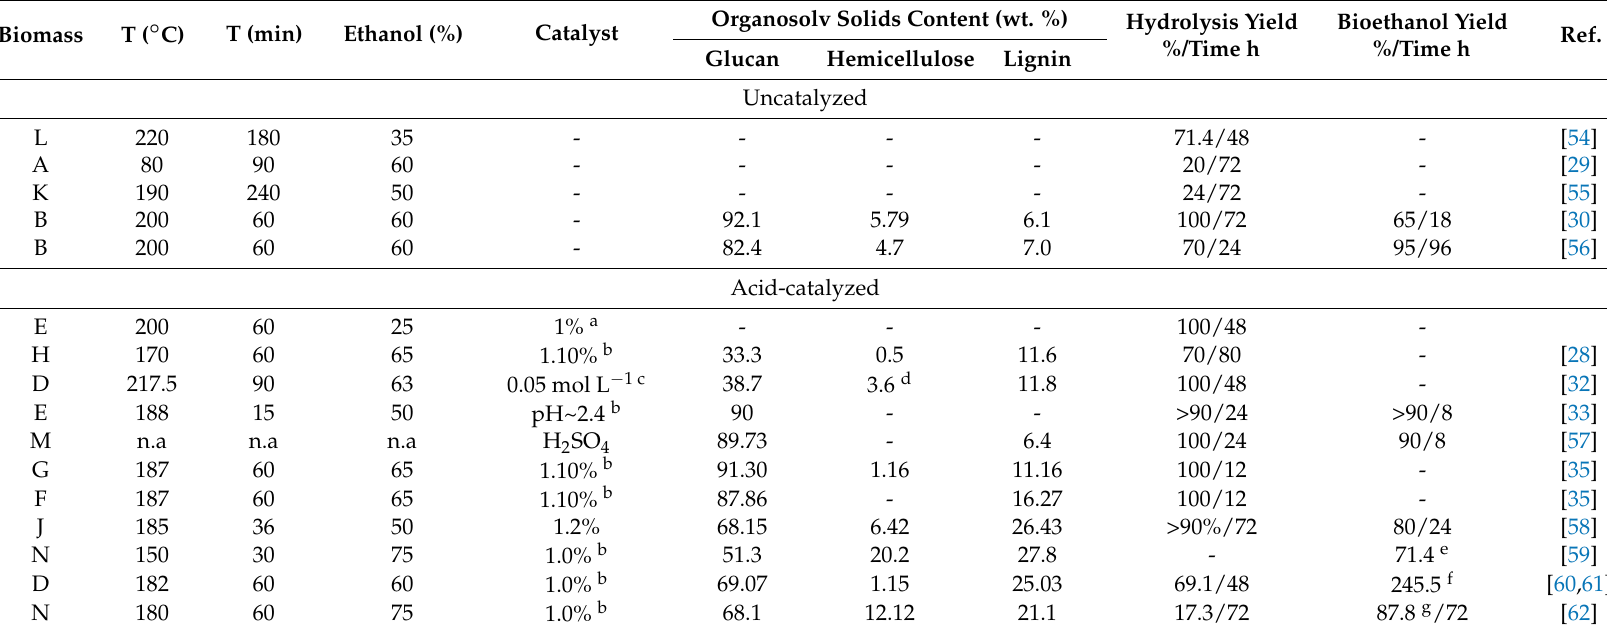
Table 2. Composition of organosolv pretreated biomass, enzymatic hydrolysis and bioethanol fermentation yields.